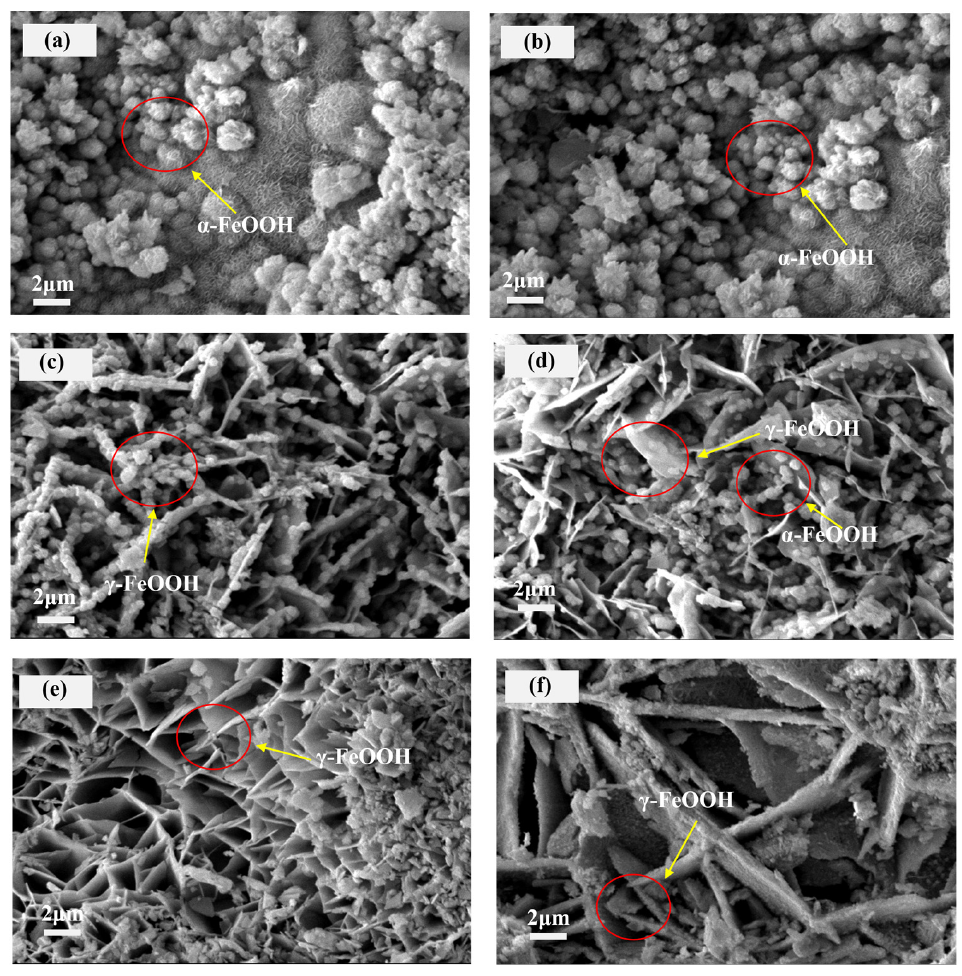
Figure 9. SEM images of corrosion products formed on the steel with interference of different AC intensities: ( a ) single steel sample without AC interference; ( b – f ) steels in coupled electrodes; AC intensities are 0 A/m 2 , 10 A/m 2 , 30 A/m 2 , 50 A/m 2 , 100 A/m 2 , respectively.